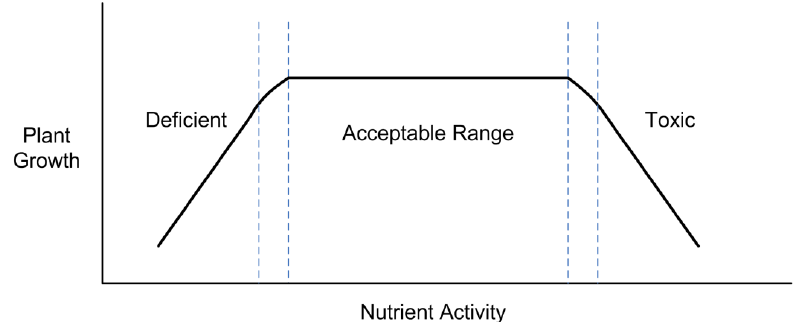
Figure 1. General principle of plant nutrient acceptable/sufficiency ranges. Dashed vertical lines represent marginal zones between acceptable and deficient or toxic nutrient